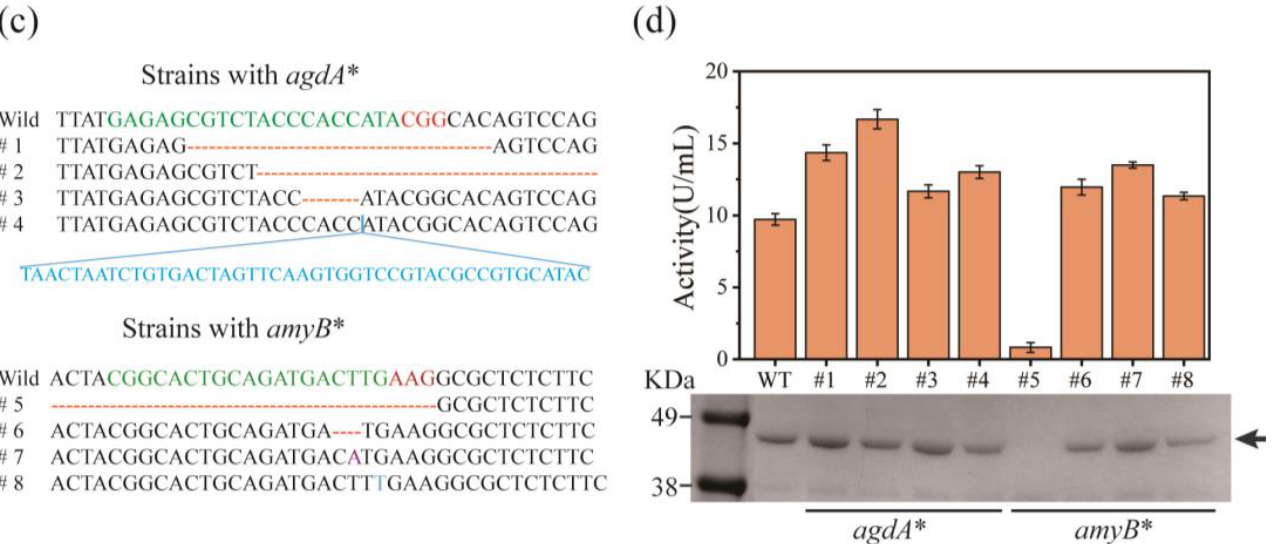
Figure 3. CRISPR/Cas9 mediated dual gene editing in A. oryzae . ( a ) Schematic diagram of editing plasmids and their target sequences. The bases underlined in red represent the PAM sequence. ( b ) The editing efficiency of double genes by CRISPR/Cas9 system. The “target gene in yellow” represented the editing of another target gene ( agdA , amyB , or ku70 ) in the selected yellow colonies ( ∆ yA ). n = 5. ( c ) Sequence profile of selected mutant strains. Green, red, orange, blue, and purple letters represent the protospacer, PAM, deletion, insertion, and mutated sequences, respectively. * means the gene contains mutations. ( d ) Enzyme activity and protein expression level of α -amylase in mu- tant strains.